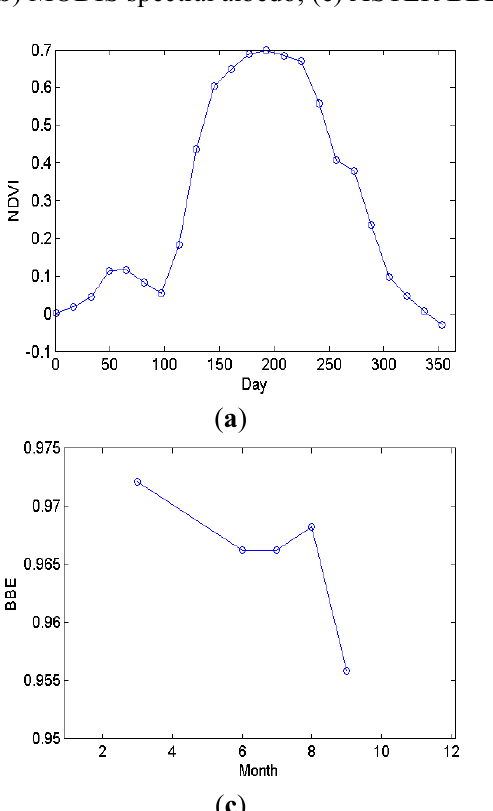
Figure 9. The calculated parameters for a homogeneous deciduous needle leaf forest site using coregistered MODIS and ASTER data from 2000 through 2010. ( a )